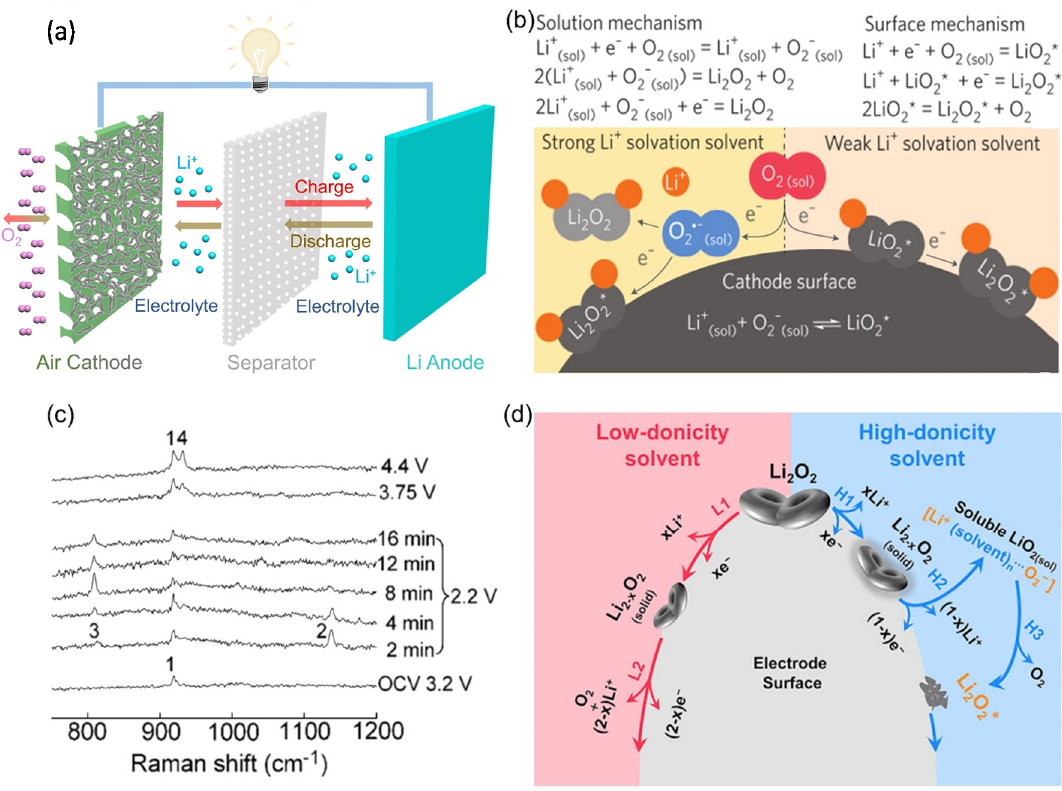
Figure 1. ( a ) Schematic illustration of rechargeable aprotic Li-O 2 battery system. ( b ) Proposed mechanisms for Li 2 O 2 growth in Li-O 2 batteries. ( c ) In situ SERS during O 2 reduction and re-oxidation on Au positive electrode. ( d ) Proposed solvent-controlled Li 2 O 2 decomposition mechanism. ( b ) Reproduced with permission from Ref. [25], copyright 2016, Nature Publishing Group. ( c ) Reproduced with permission from Ref. [26], copyright 2011, Wiley-VCH. ( d ) Reproduced with permission from Ref. [34], copyright 2018, Elsevier.